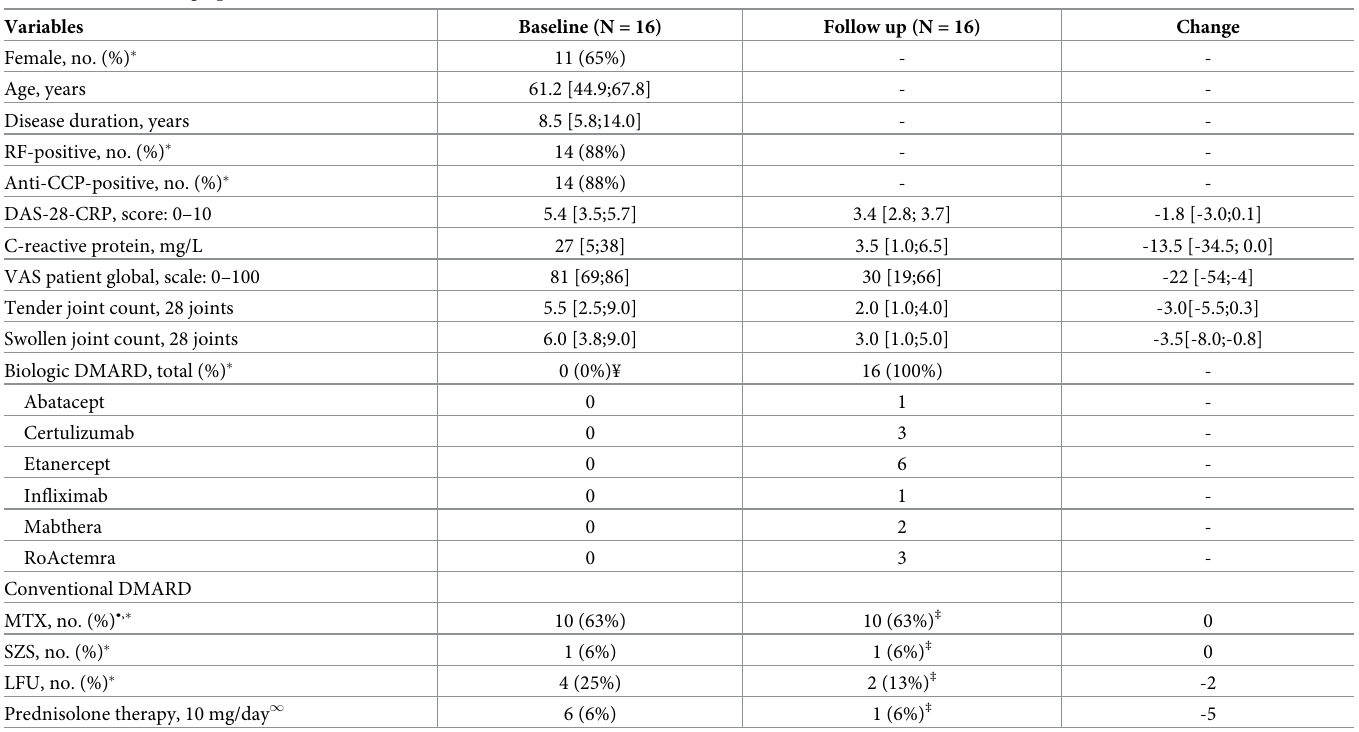
Table 1. Patient demographics and clinical